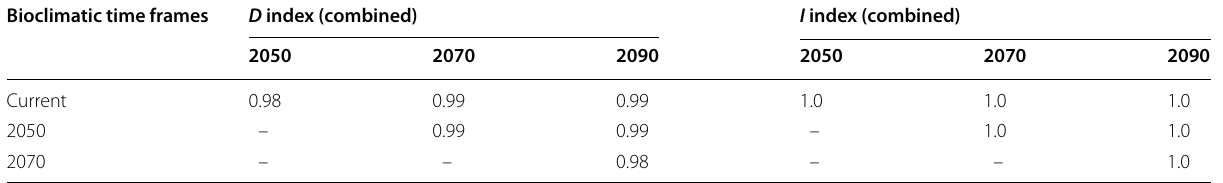
Table 11 Niche overlap Schoener’s D and Hellinger’s I values between various bioclimatic and non-bioclimatic variables for combined data set